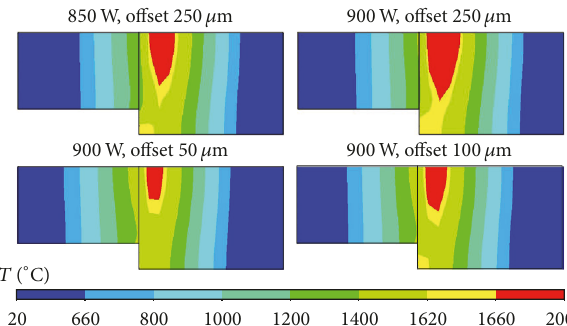
Figure 12: Temperature fields in the cross sections perpendicular to the Al-Ti weld centre through the node 𝑃 in the time of 1 second illustrating the effect of laser offset and the laser